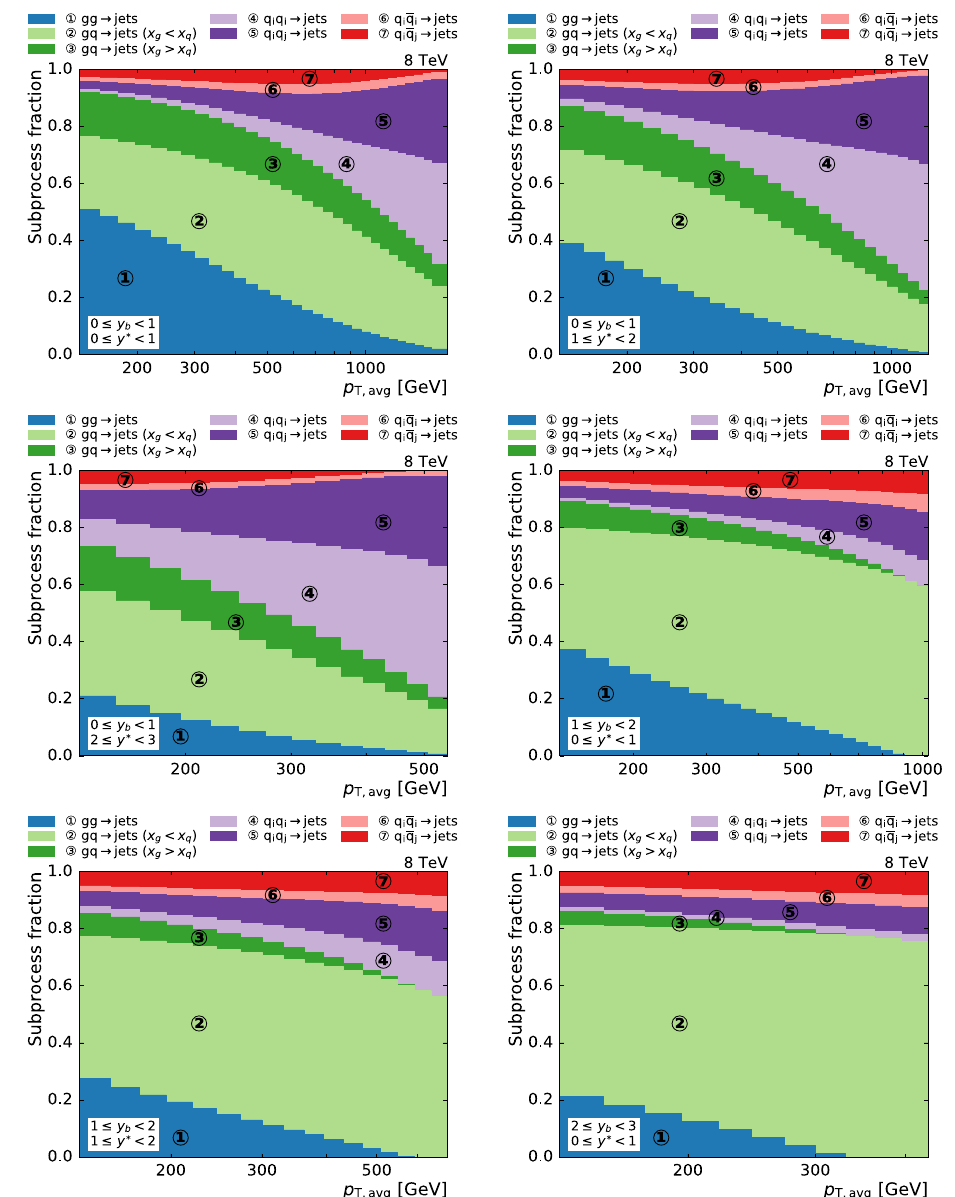
the type of the incoming partons. The calculations have been performed with NLOJet++ . The notation implies the sum over initial-state parton flavors as well as interchanged quarks and antiquarks